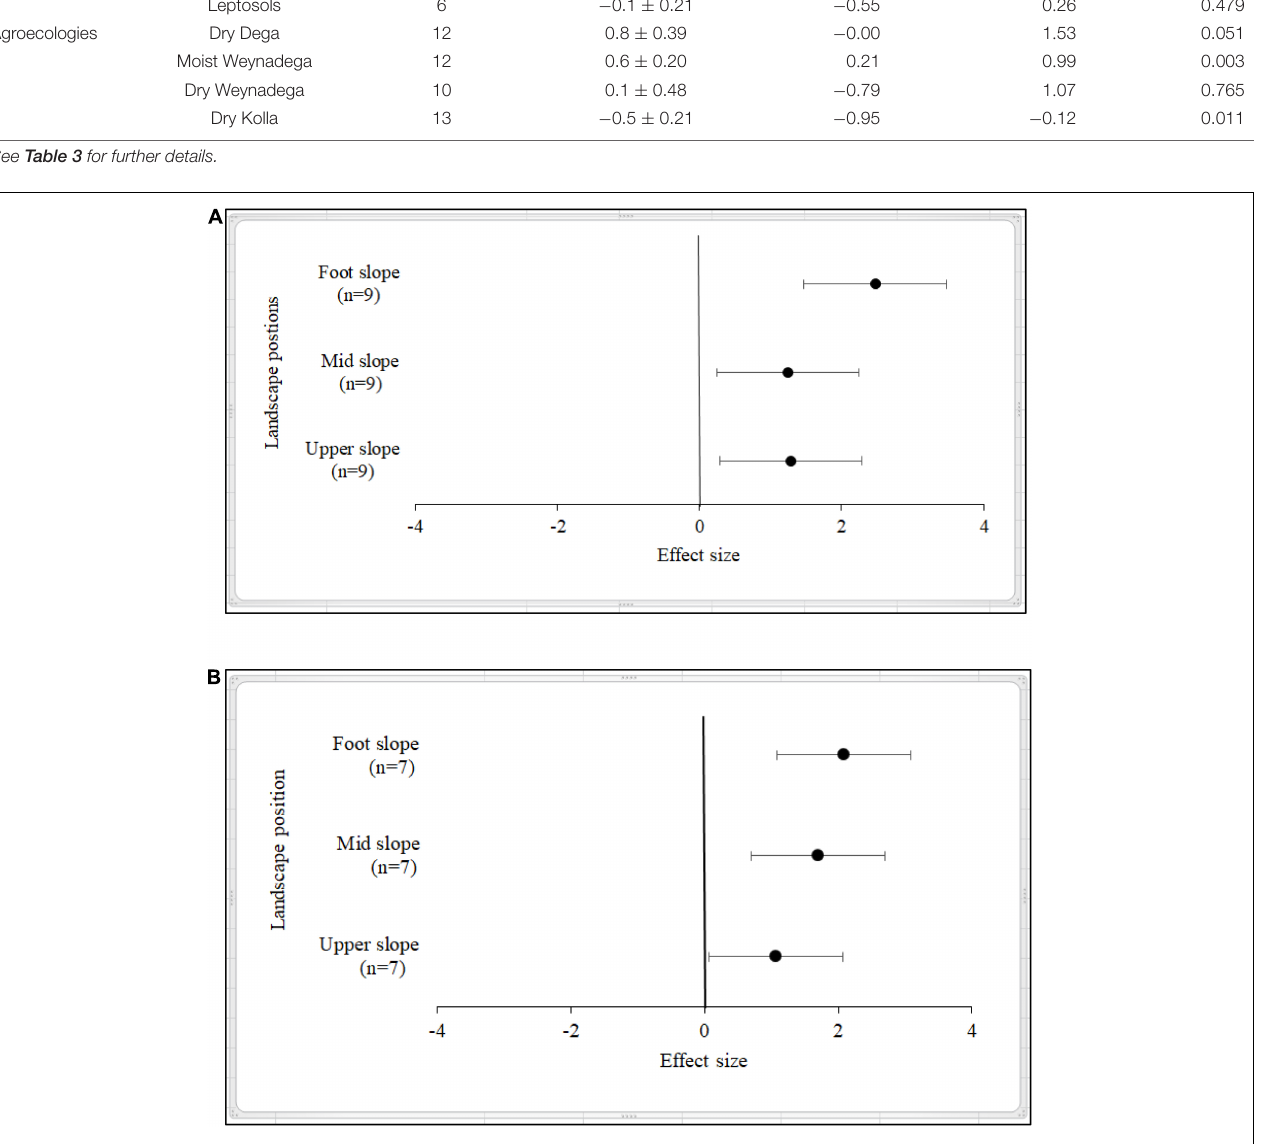
FIGURE 9 | Changes in soil organic carbon (A) and total soil nitrogen (B) following establishment of exclosures on communal grazing lands under three landscape positions; Foot slope, Mid-slope and Upper slope. See Figure 5 for further